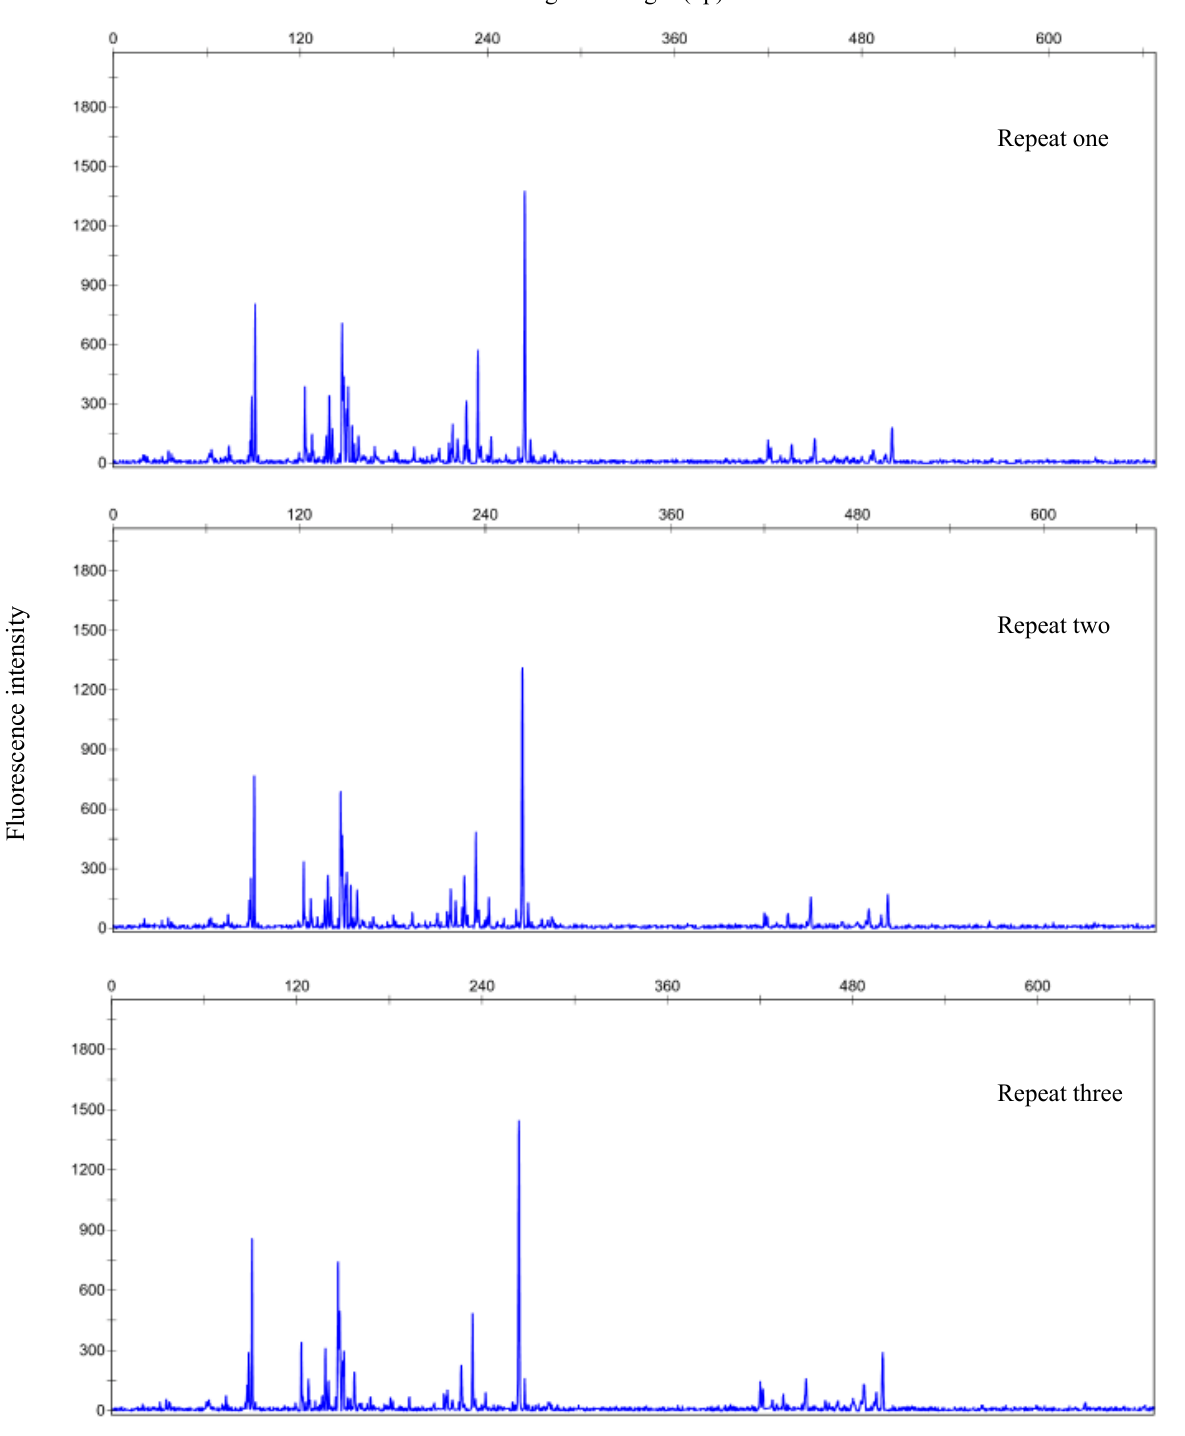
Fig. S2: T-RFLP chromatogram of fungi in rhizosphere soil of tea tree with pH value of